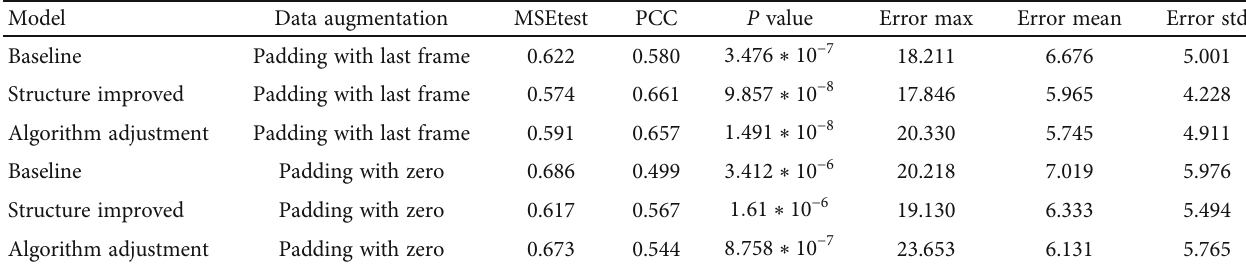
Table 4: Evaluation of 3 models with data